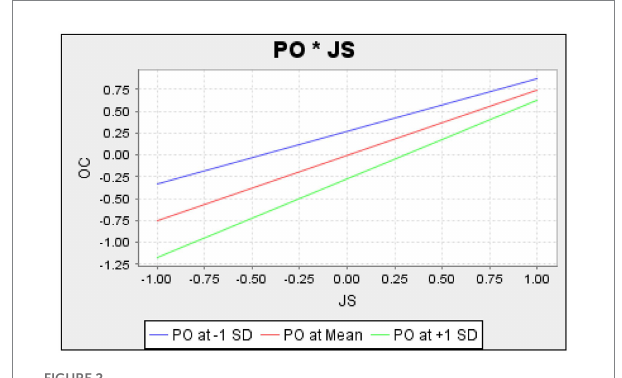
FIGURE 2 Moderation effect of P–O fit between job satisfaction and organizational commitment.